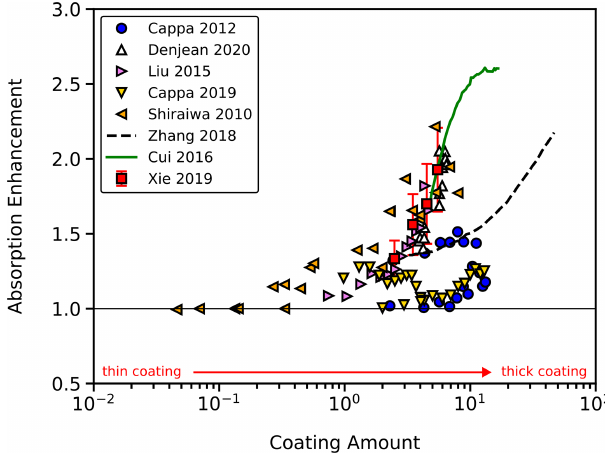
Figure 1. Results from previous studies on light absorption en- hancement. Some studies find high absorption enhancement, which have had large discrepancies. Some studies find that absorption is enhanced by over twofold, while other studies find little to no ab- sorption enhancement with increased coating amount (Cappa et al., 2012; Denjean et al., 2020; Liu et al., 2015; Cappa et al., 2019; Shi- raiwa et al., 2010; Zhang et al., 2018; Cui et al., 2016; Xie et al.,